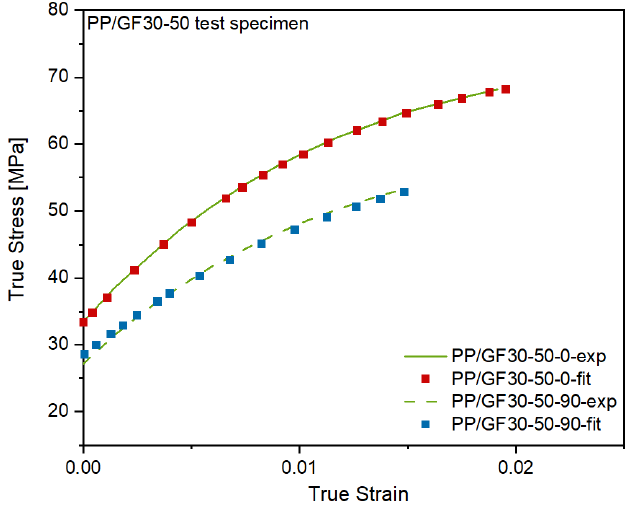
Figure 10. Experimental and fitted stress-strain-curves of the PP/GF30 short fiber-reinforced thermo- plastic composite in flow direction and perpendicular to it. Table 4. Numerical simulation input parameters of the PP/GF30 short fiber-reinforced thermo- plastic composite.